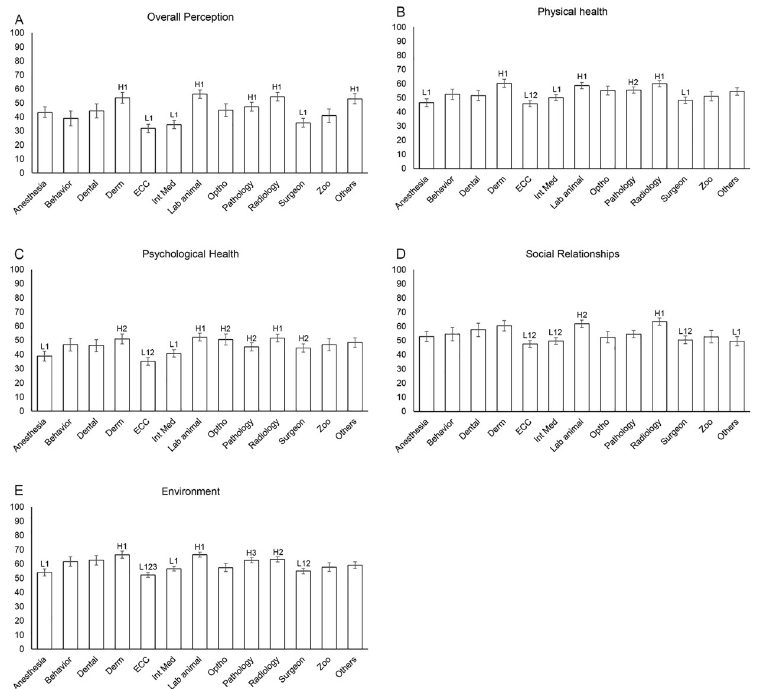
Fig 2. Bar charts comparing the mean ( ± SE) standardized QOL domain scores (A to E) among 13 veterinary resident specialty groups. H and L indicate significant comparison (i.e., Bonferroni adjusted P < 0.05) between high QOL (H) and low QOL (L) scores. The numbers further group significant results together. For example, the mean Physical health score for ECC is significantly lower (L12) than the mean scores for Dermatology (Derm; H1), Lab animal (H1), Radiology (H1), and Pathology (H2). P-values and SE are derived from general linear models, adjusting for significant covariates identified in the univariate